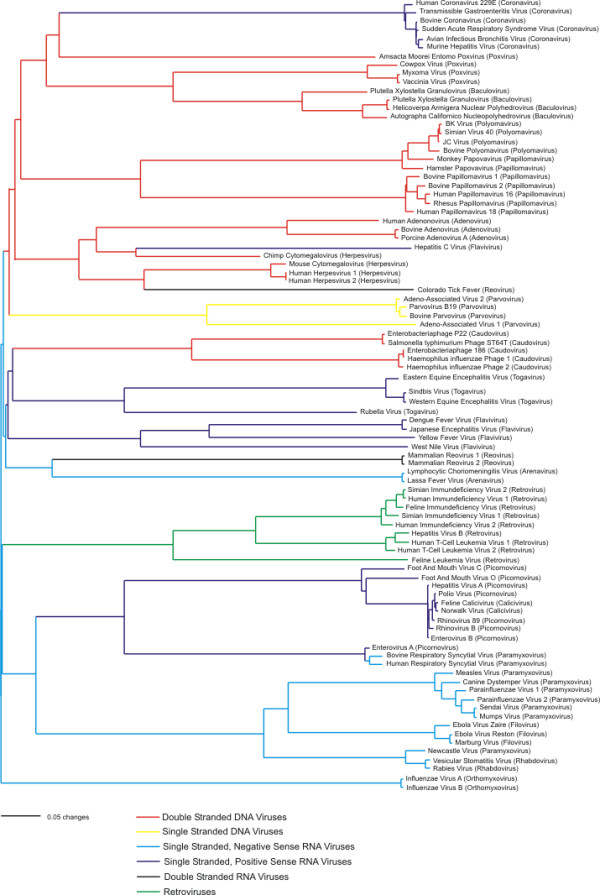
Phylograms of 90 selected viruses for which genomic sequences are available. The organisms were grouped according to distance matrices based on the number of shared orthologues between each genome, as described in Materials and Methods. Phylogenies were created by neighbor-joining analysis. Color code as is for Figure 7. The branch length index is indicated below the phylogeny.